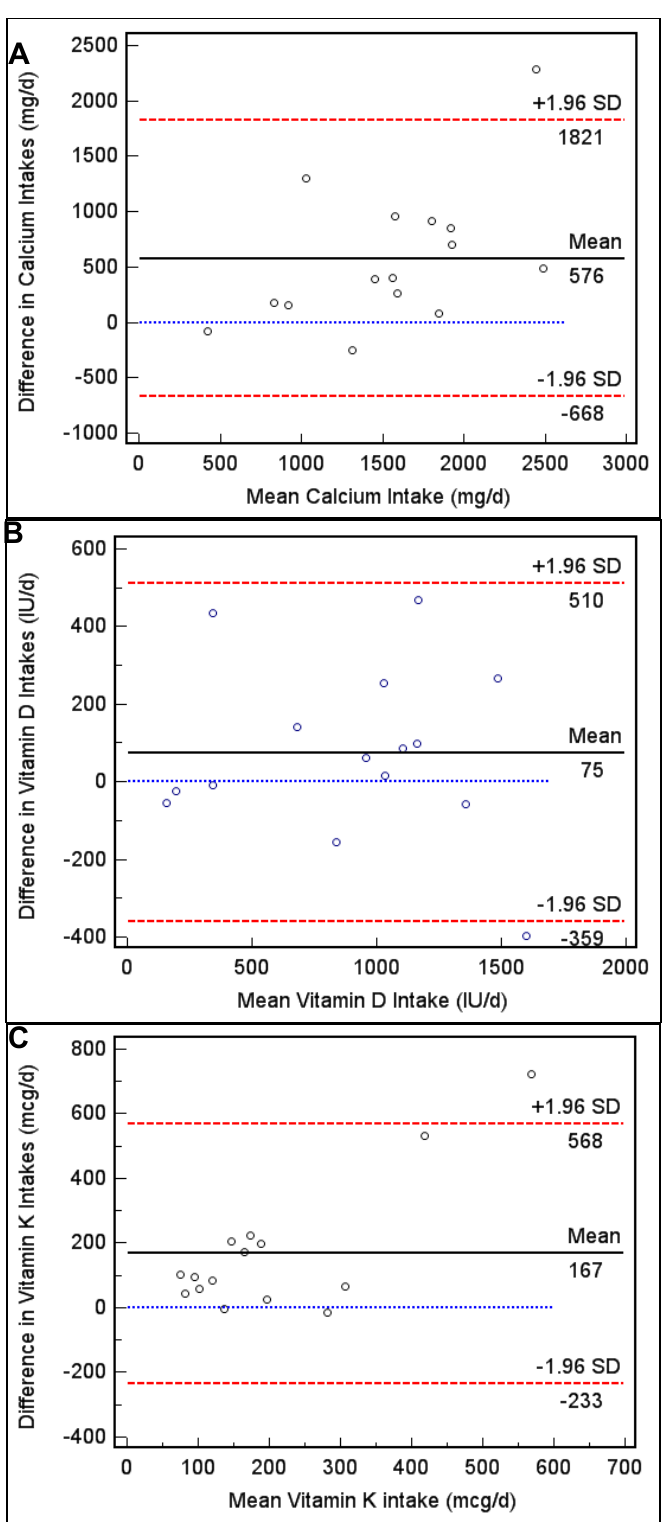
Figure 1. (A) Bland-Altman plots to assess agreement and systematic difference between the FFQ and 5DDR for calcium intake, (B) vitamin D intake and, (C) vitamin K